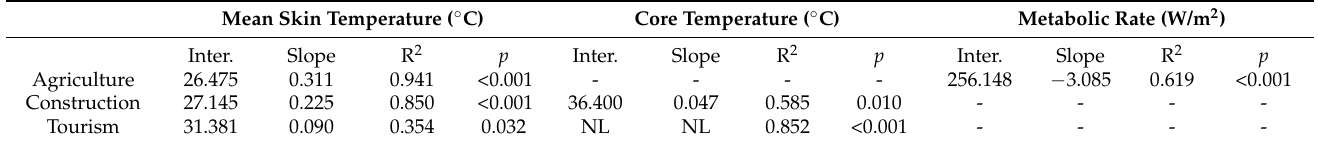
Table A2. Results of all regression analyses. Dash signs indicate no statistically significant results. NL indicates that a non-linear regression (if WBGT < 30 ◦ C then core temperature = 37.17043 + WBGT ∗ 0.01007; if WBGT > 30 ◦ C then core temperature = 37.17043 + WBGT ∗ 0.39051) was conducted to examine the impact of occupational heat stress on the core temperature of tourism workers.